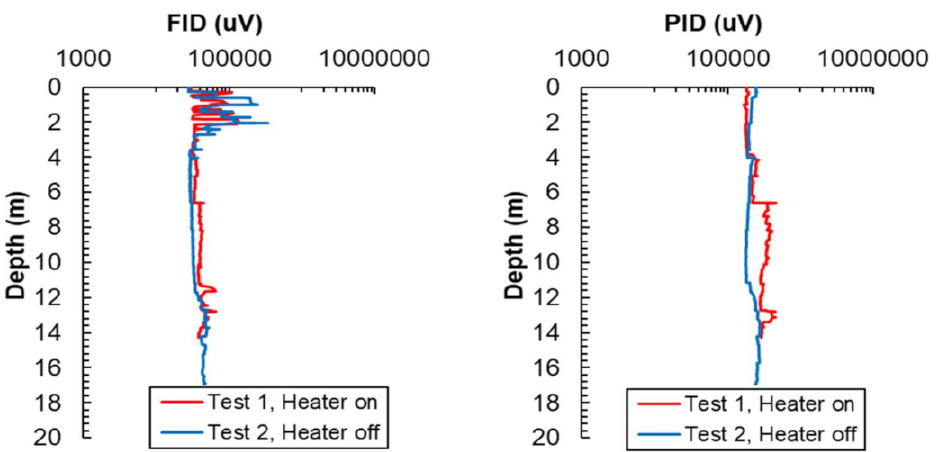
Figure 3. Flame ionization detector (FID) and photoionization detector (PID) responses for the MIP test at the Butler County